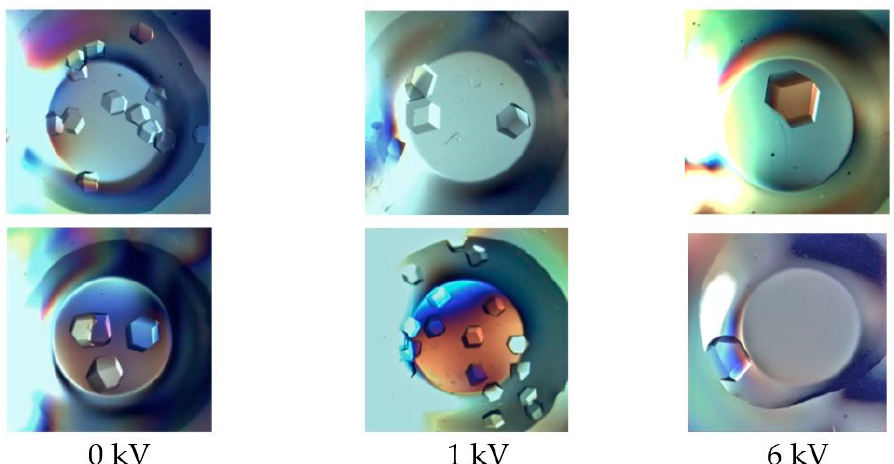
Figure 7. Efield microbatch crystals of Glucose Isomerase from Streptomyces rubiginosus in the presence of different DC electric field intensities. Each experiment consisted of five 72-well microbatch crystallization plates (Hampton Research). For the experiments, 1 µ L of protein (Glucose Isomerase) and 1 µ L of precipitant solution (sodium citrate) and 10 µ L of mineral oil were placed in each well. The trials were exposed to five different DC voltages: 0, 1, 2, 4, and 6 kV for a 48-h period. The top and bottom panels are typical results from experiments realized on separate dates.